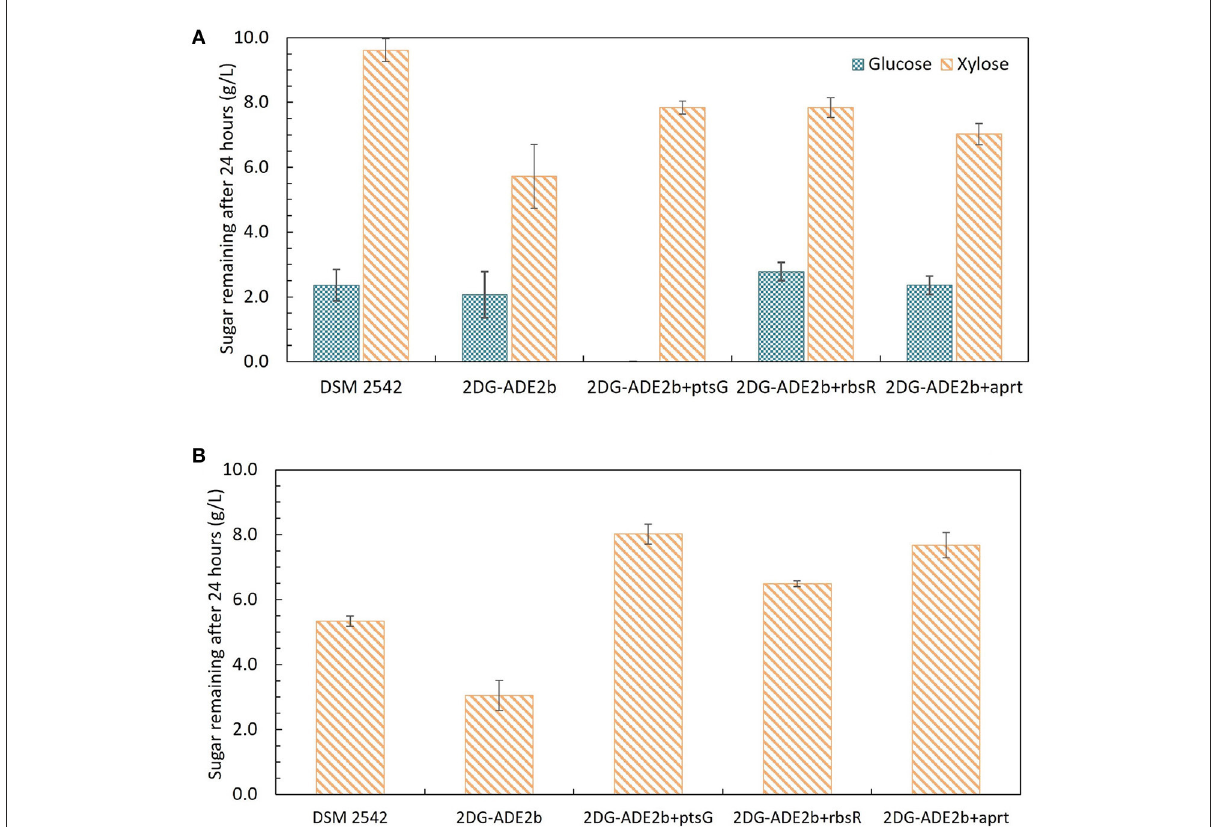
FIGURE9 Sugar consumption profiles of P. thermoglucosidasius DSM 2542, 2-DG evolved strains 2DG-ADE2b, and 2DG-ADE2b variants with plasmid pJL- ptsG + (2DG-ADE2b ptsG + ), pJL- apt + (2DG-ADE2b apt + ) and pJL- rbsR + (2DG-ADE2b rbsR + ), respectively. Cells were grown in 15 mL sterile centrifuge tubes in ASM medium supplemented with (A) 1% (w/v) glucose and 1% (w/v) xylose, or (B) 1% (w/v)xylose. To stabilize the pH during the fermentation, 0.2 g MgCO 3 was added to the tubes prior to inoculation. Error bars are ± standard deviation of three replicates taken at the same time point. T -test confirmed the remaining glucose and xylose in each culture in (A) were statistically different ( p < 0.05), and the remaining xylose in (B) was statistically different from each other ( p <